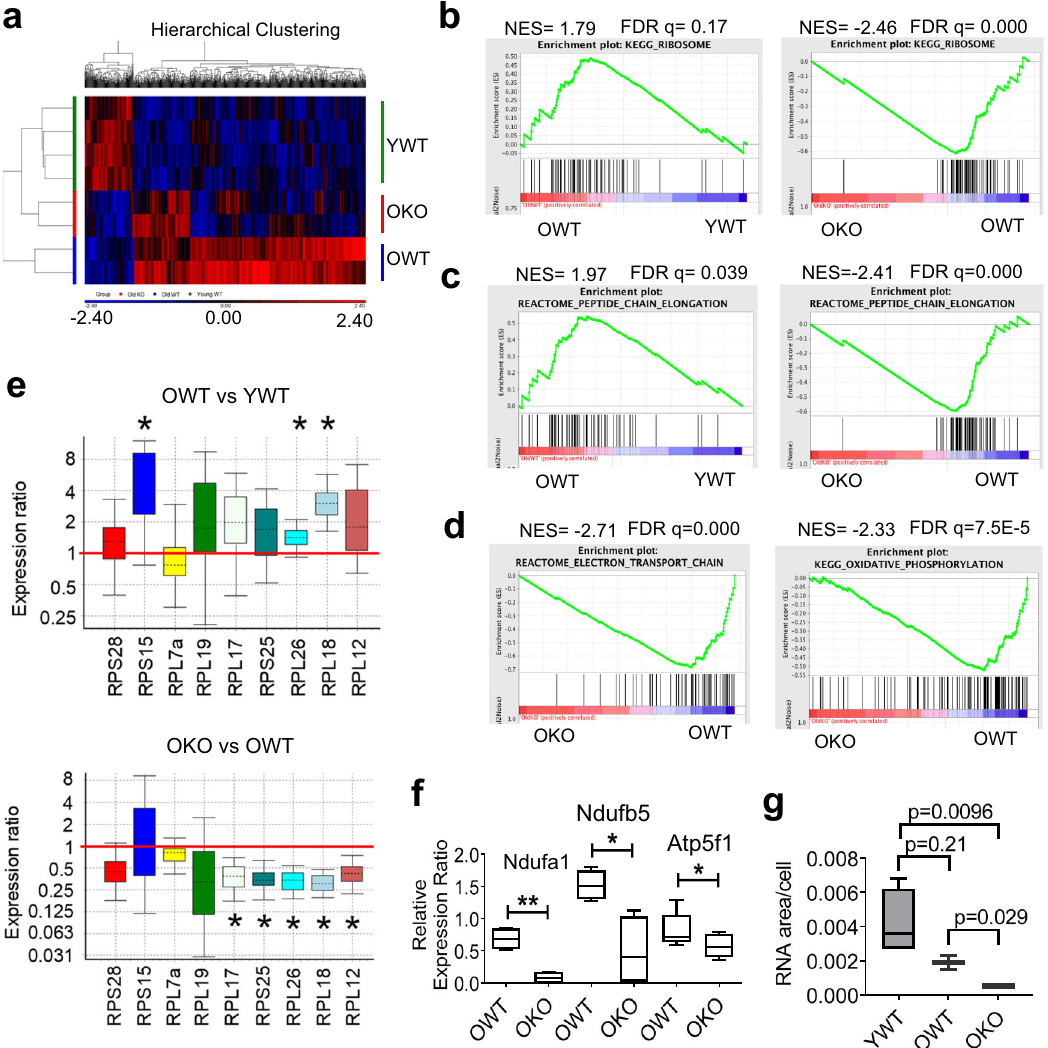
Fig. 7 Sirt1 knockout reduced age-dependent changes of molecular pathways in aging HSCs. a Hierarchical clustering of microarray gene expression in SP cells. b – d GSEA plots for ribosomal genes ( b ), peptide chain elongation ( c ), and electron transport chain/OXPHOS ( d ). The method for ranking genes was the default “ Signal2Noise, ” and the scoring scheme was also the default “ weighted ” . GSEA plots were ranked by NES and the full sets of results were provided in Supplementary Data 1 and 2. e OWT/YWT and OKO/OWT gene expression ratio of ribosomal genes analyzed by real time RT-PCR. f Real time RT-PCR analysis of top ranked OXPHOS genes in OWT and OKO HSCs. g Analysis of 18S + 28S rRNA of HSCs by Agilent Bioanalyzer. * P < 0.05; ** P < 0.01. Error bars represented one standard